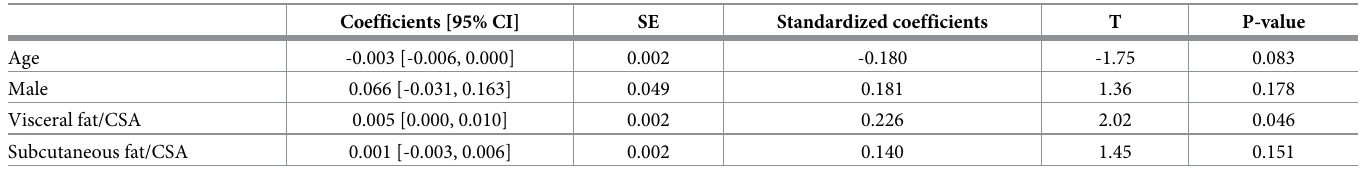
Table 7. Multiple regression analysis based on CT data (30 min after the surgical incision).